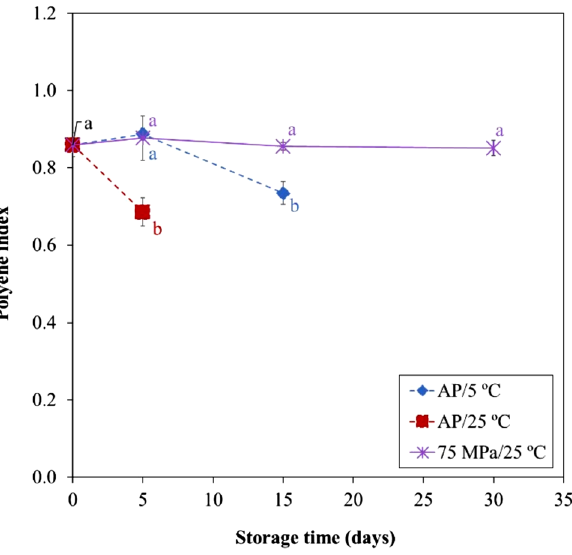
Figure 1. Polyene index of Atlantic salmon stored at 75 MPa/25 °C, AP/5 °C and AP/25 °C during 30, 15 and 5 days, respectively. Different letters denote significant differences (p < 0.05) between salmon samples stored at different conditions and time ( a , b